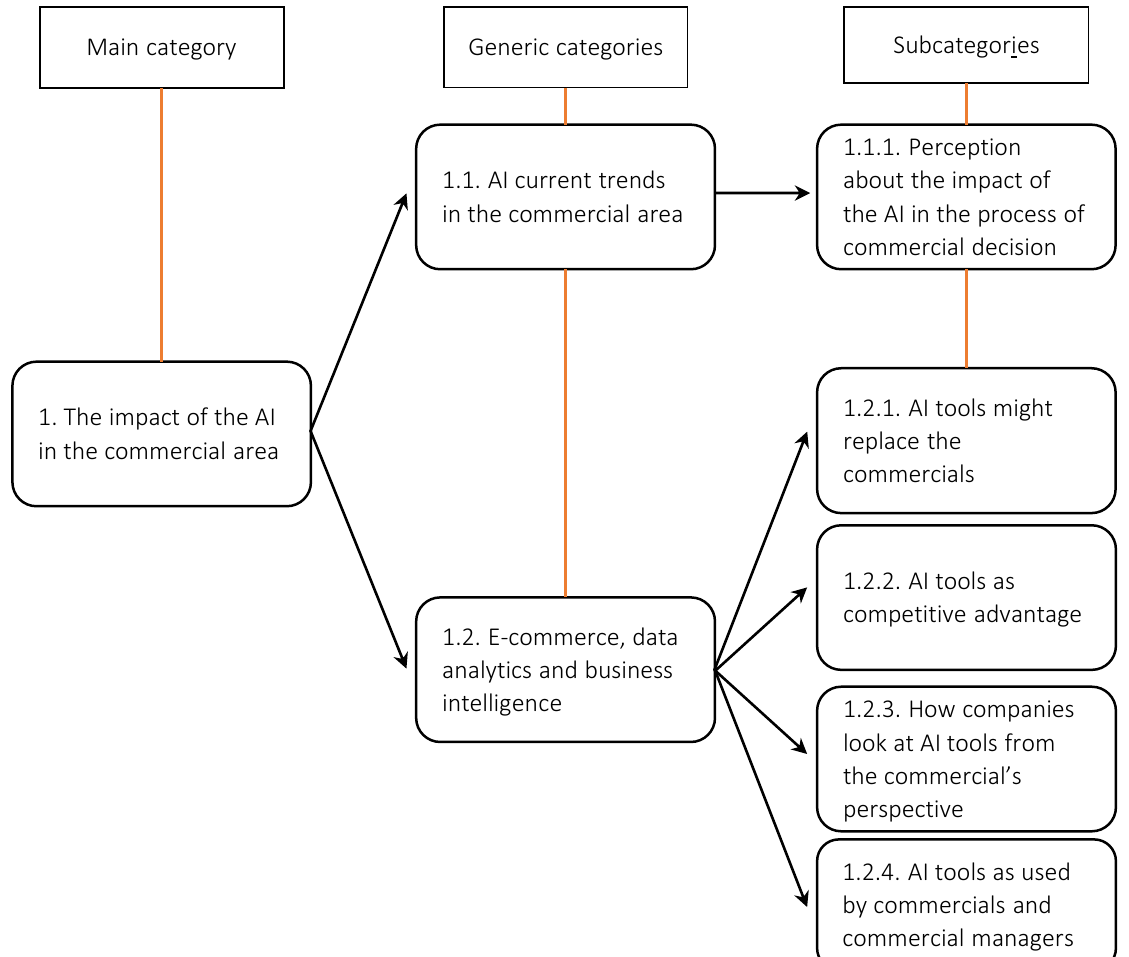
Figure 1. Categorization and coding of the interview corpus for qualitative